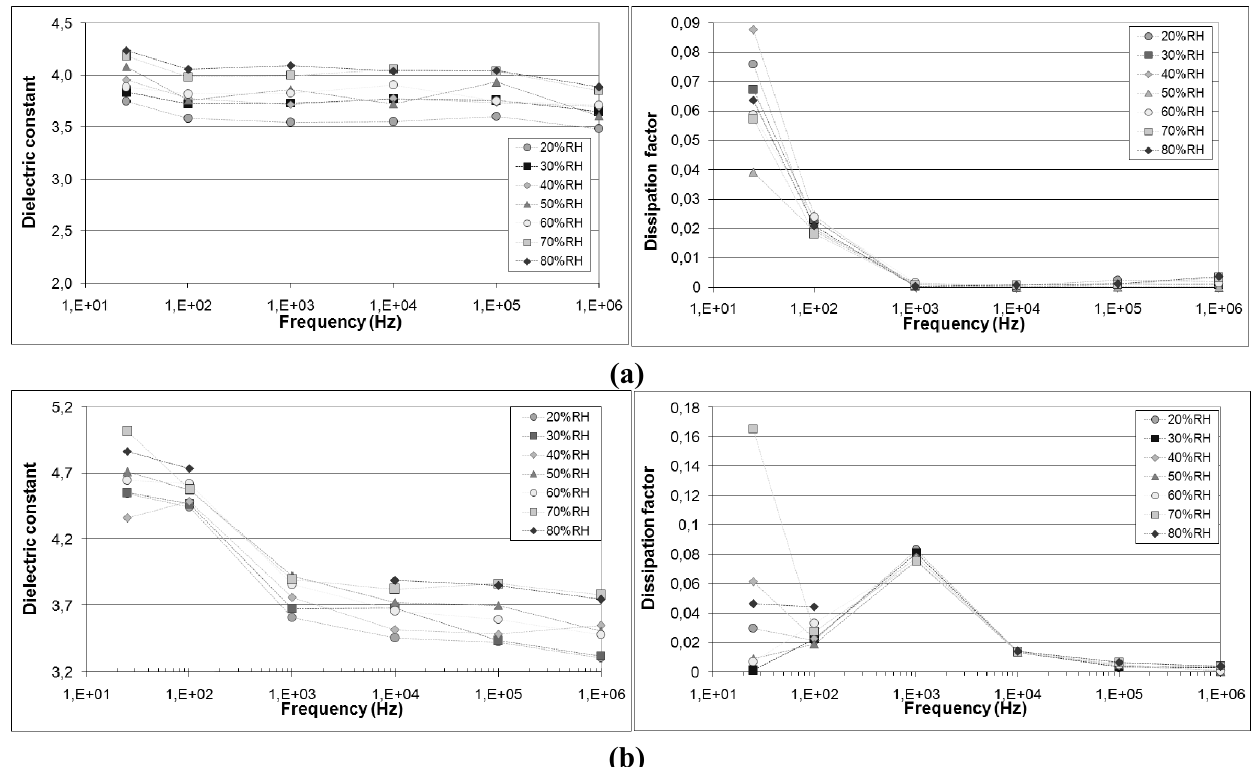
Figure 8. (a) Dielectric characteristics of a virgin humidity sensor; (b) Evidence of physical ageing of the humidity